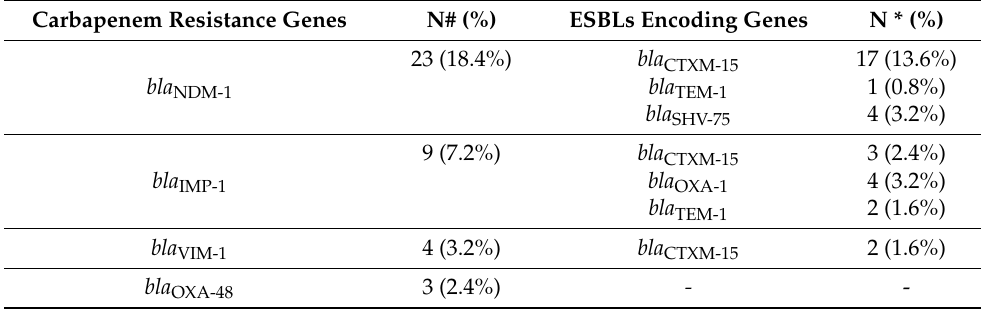
Table 1. Prevalence of antibiotic resistance genes (alone or in coexistence) investigated in the present